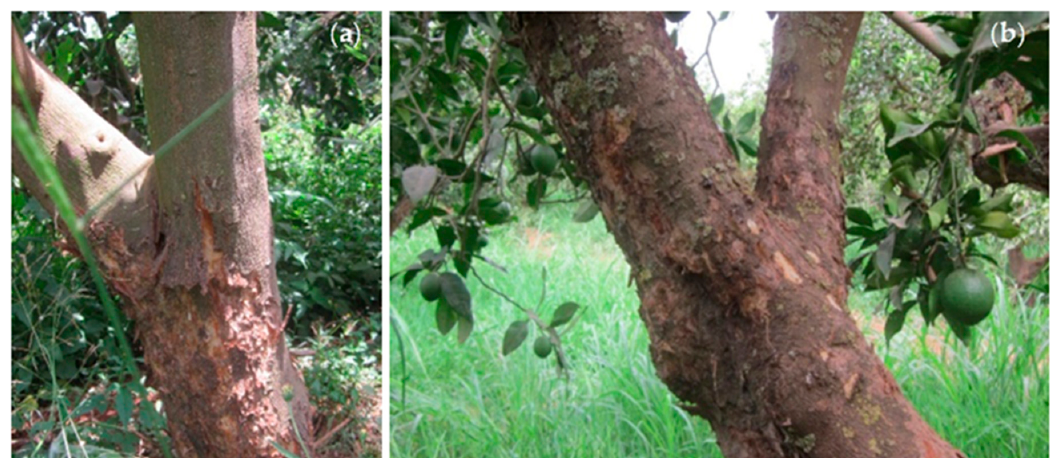
Figure 2. Field symptoms of citrus psorosis disease observed in Moroccan citrus orchards in the Moulouya region in 2019. ( a ) Bark scaling and gumming restricted to the stem and main branches of sweet orange trees, characteristic of psorosis A (PsA); ( b ) rampant bark scaling affecting thin branches of sweet orange trees, characteristic of PsB..